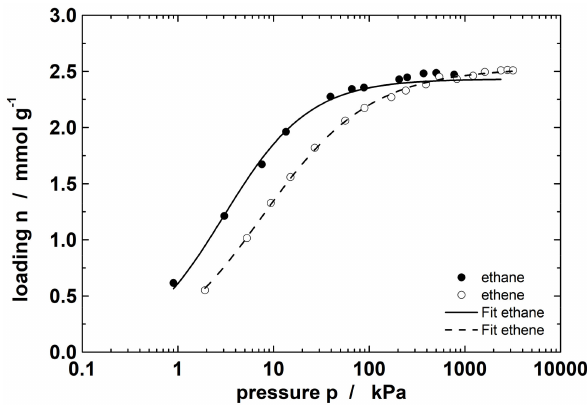
Figure 1. Adsorption isotherm of ethane and ethene at 20 ◦ C on ZIF-4 and the respective fit data from the Toth model.